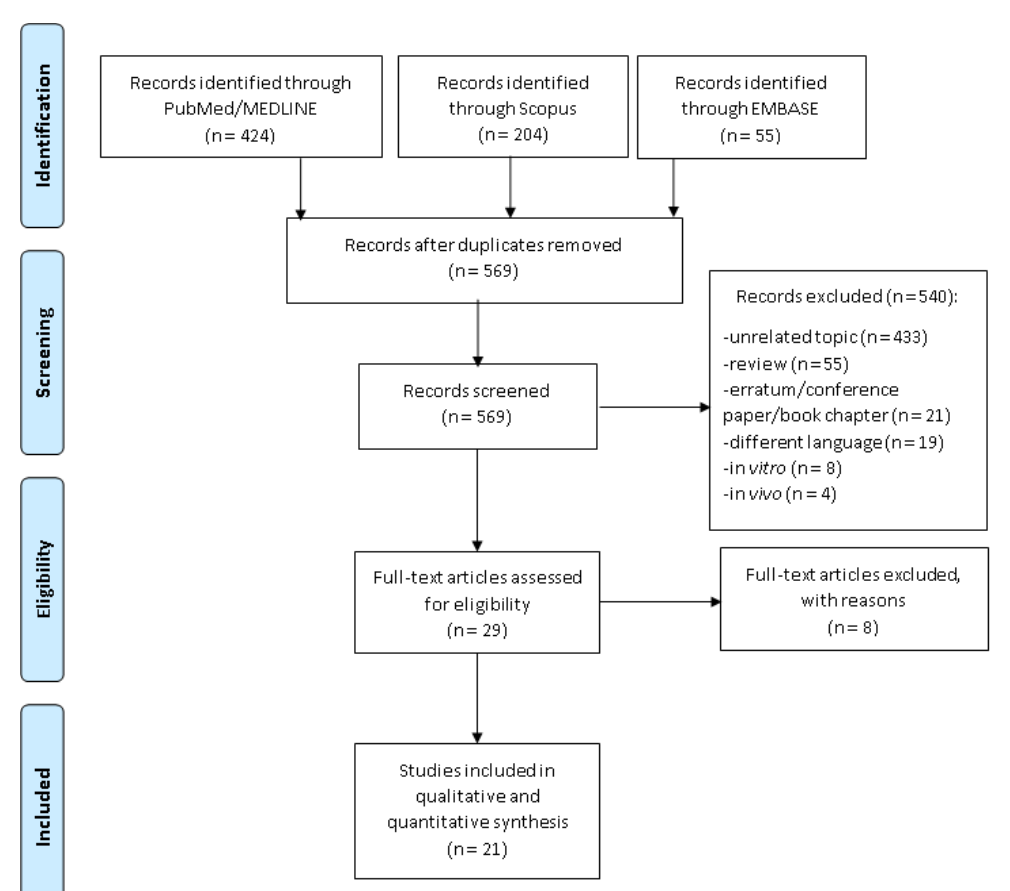
Figure 1. Flow diagram of the studies’ selection process.